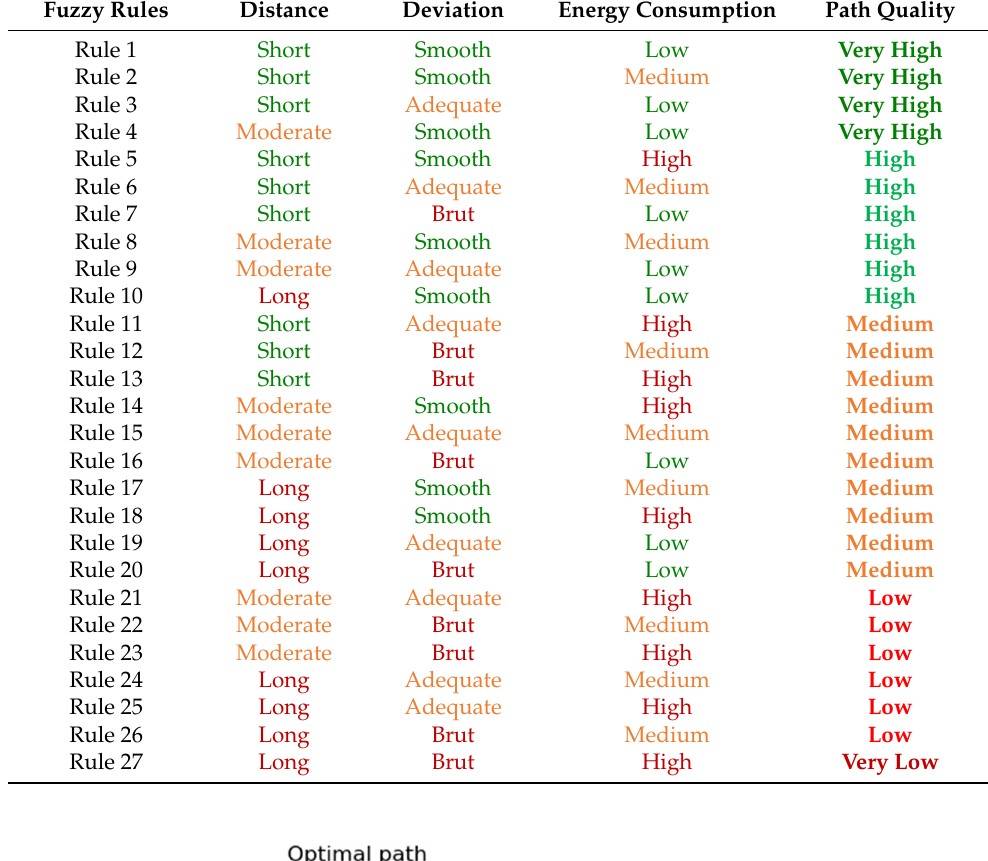
Table 1. The fuzzy rules adopted for the FIS.